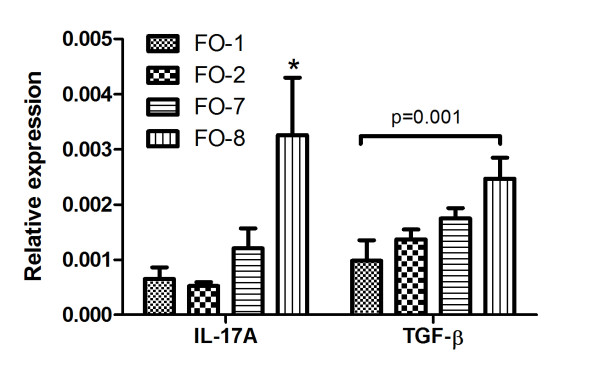
Cytokine genes expressed in the head kidney of Atlantic salmon injected with different oil-based vaccines. qPCR expression studies of IL17A and transforming growth factor β (TGF-β) genes identified as upregulated by microarray. FO-1 = A. salmonicida (sc); FO-2 = A. salmonicida (6 × sc); FO-7 = M. viscosa (sc); FO-8 = M. viscosa (6 × sc). Gene expression ratios normalized to EF1α. Error bars = SE, n= 7. *p < 0.05.